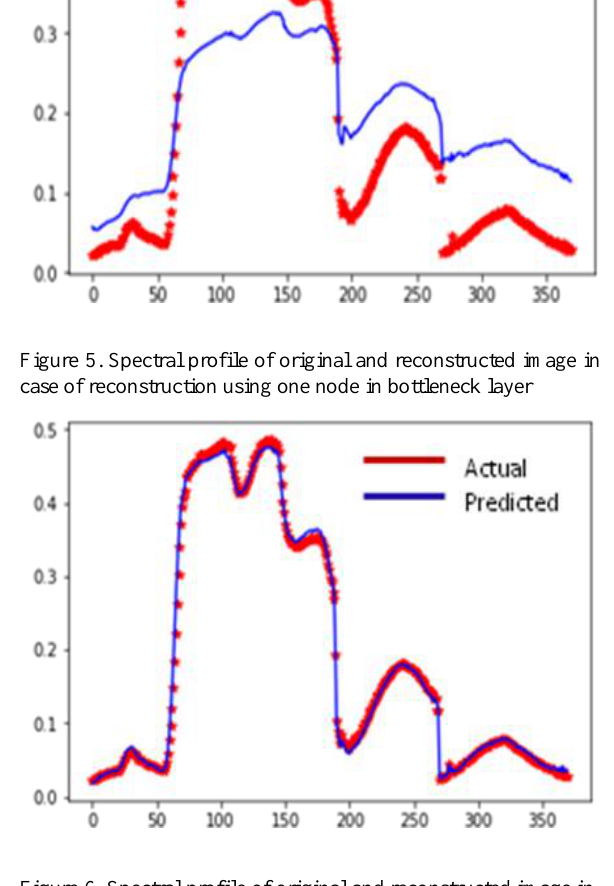
Figure 6. Spectral profile of original and reconstructed image in case of reconstruction using ten nodes in bottleneck layer